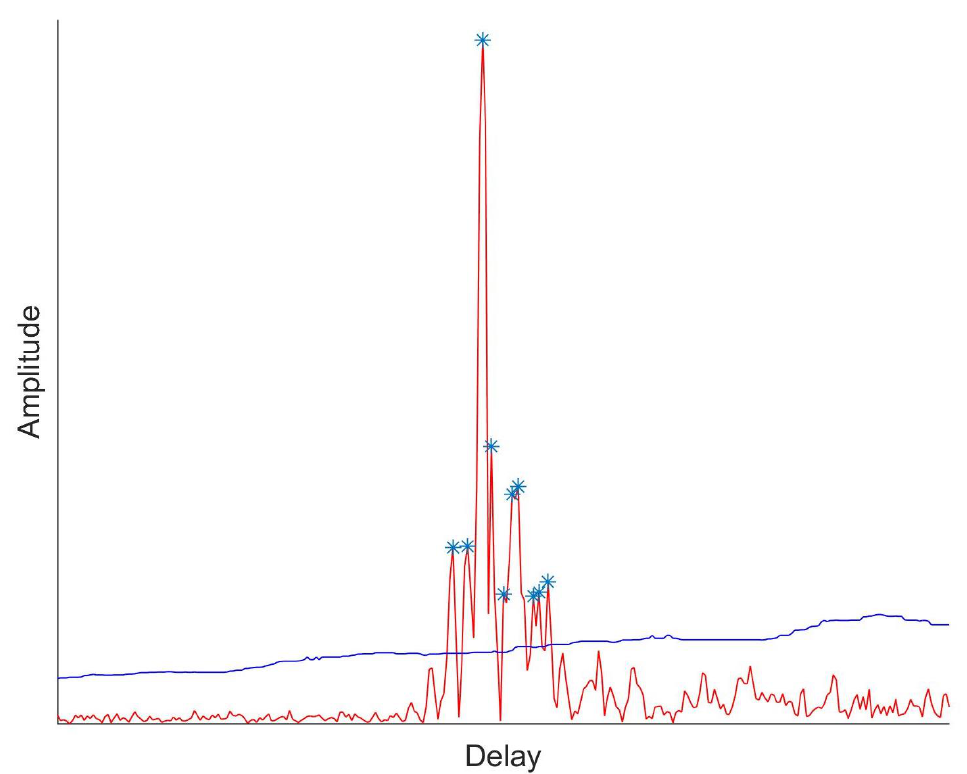
Figure 4. CIR signal pretreatment result before the characteristic factors’ calculation. The CIR is represented by red line. The OS-CFAR detection threshold is the blue line; the peaks marked by blue * are the detected